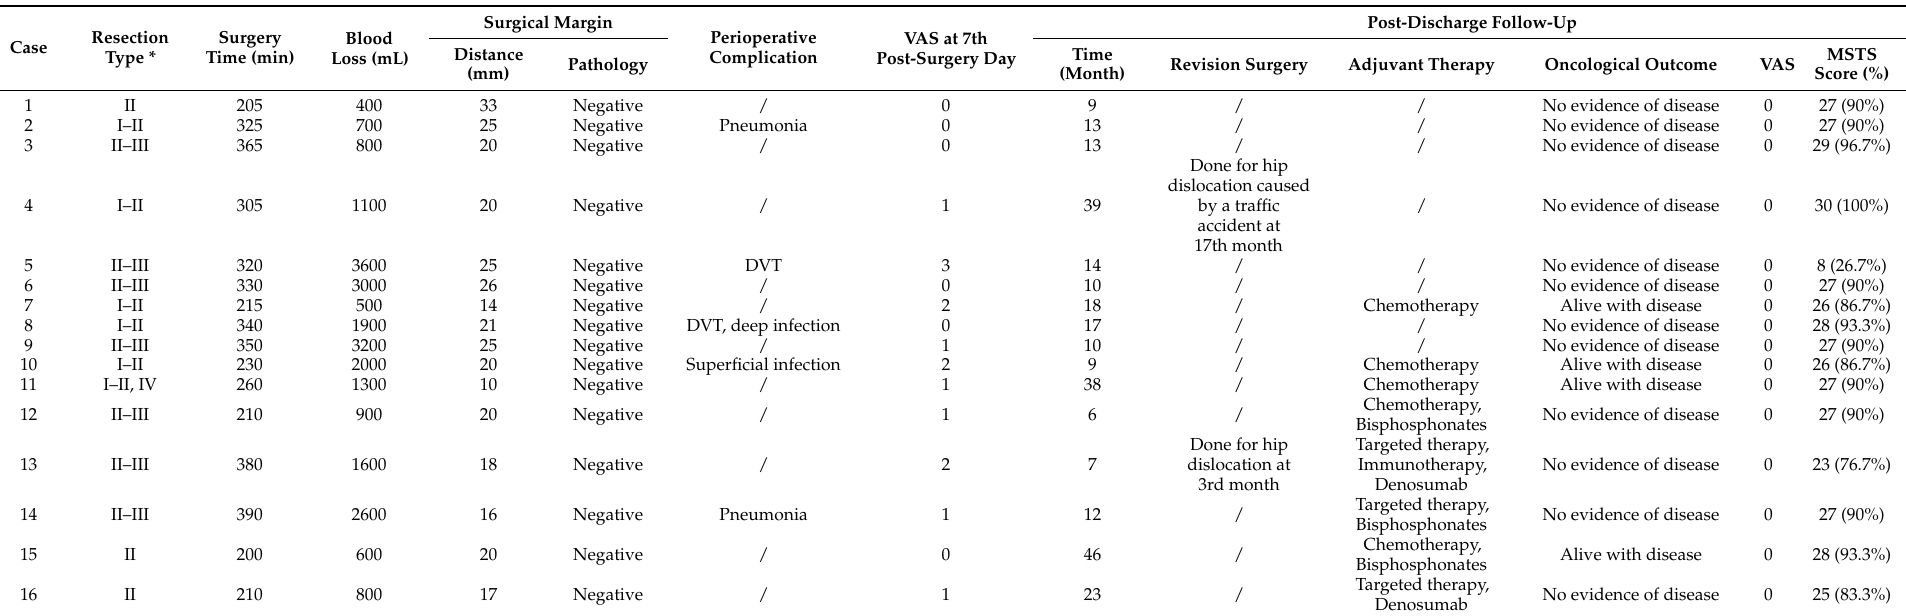
Table 2. Surgery characteristics and